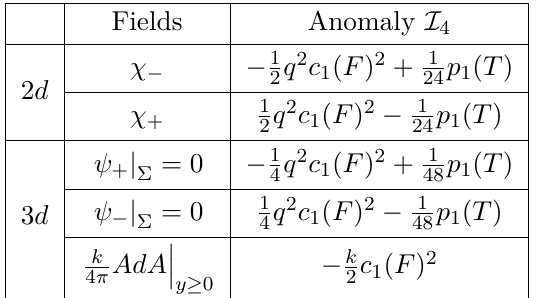
. Here the fermions carry charge q under +